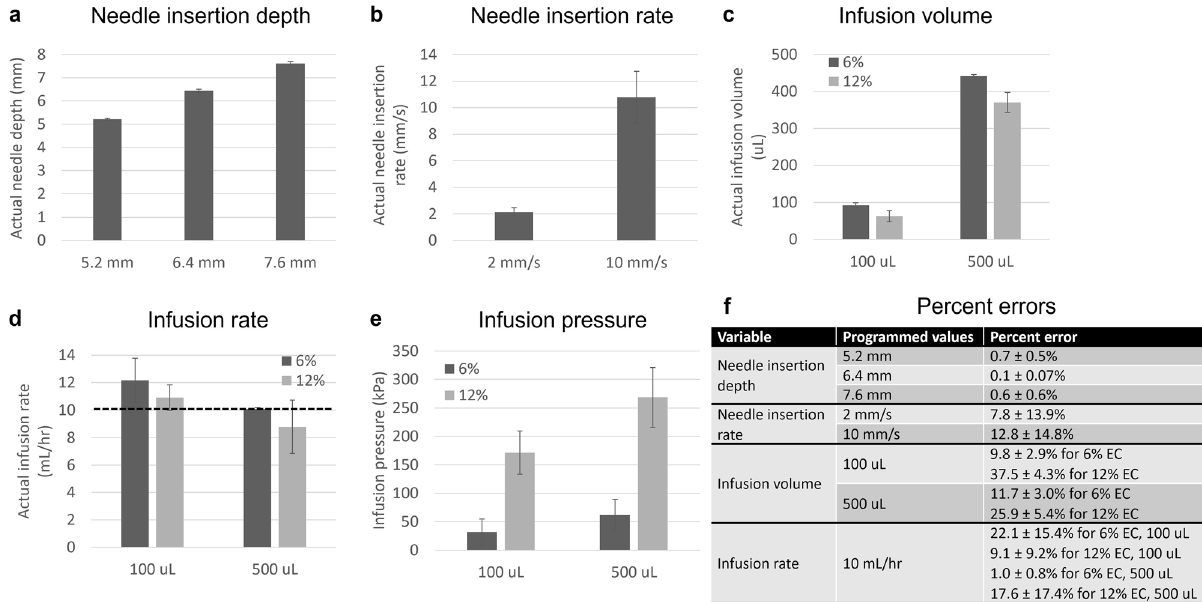
Figure 4. Injector benchtop validation. ( a ) Needle insertion depth was measured with calipers for programmed needle depths of 5.2, 6.4, and 7.6 mm. ( b ) The needle insertion rate was measured by calculating the needle movement over time for programmed needle depths of 2 and 10 mm/s. ( c ) A programmed infusion volume of either 100 or 500 µL of 6% or 12% EC-ethanol was injected into a container from which mass (and the corresponding actual infusion volume) could be measured. ( d ) The infusion rate was verified by measuring the time required to deliver programmed volumes of 100 and 500 µL into a container. ( e ) Infusion pressure was also monitored during injections with the manometer. Percent errors for all benchtop testing are summarized in ( f ). All groups had a sample size of n =